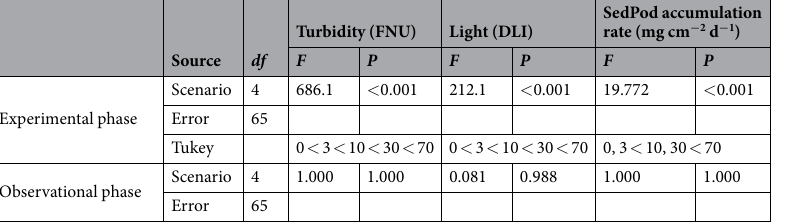
Table 2. Analyses of variance on the effect of turbidity scenario on the physical parameters. One-way ANOVA on turbidity (FNU), light (DLI) and sedimentation data, at the end of the experimental and observational phase. Tukey tests have been performed for significant pairwise multiple comparisons between scenarios (scenarios: 0, 3, 10, 30 and 70